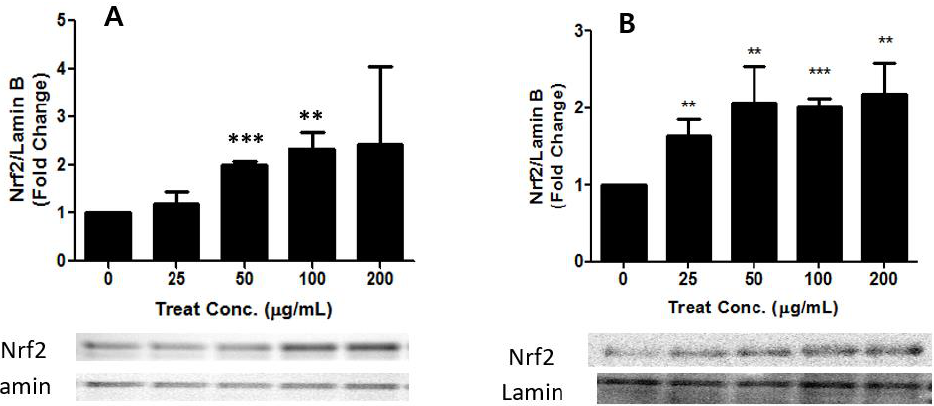
Figure 8. Activation of Nrf2 in nucleus of A549 cells after treatment with PM2.5 ( A ) and TSP ( B ). Cells were exposed to PM2.5 and TSP at 0, 25, 50, 100, and 200 µg/mL for 24 h. The values are reported as the mean ± SD (Student’s t -test, ** p < 0.01, *** p < 0.001, vs. control).